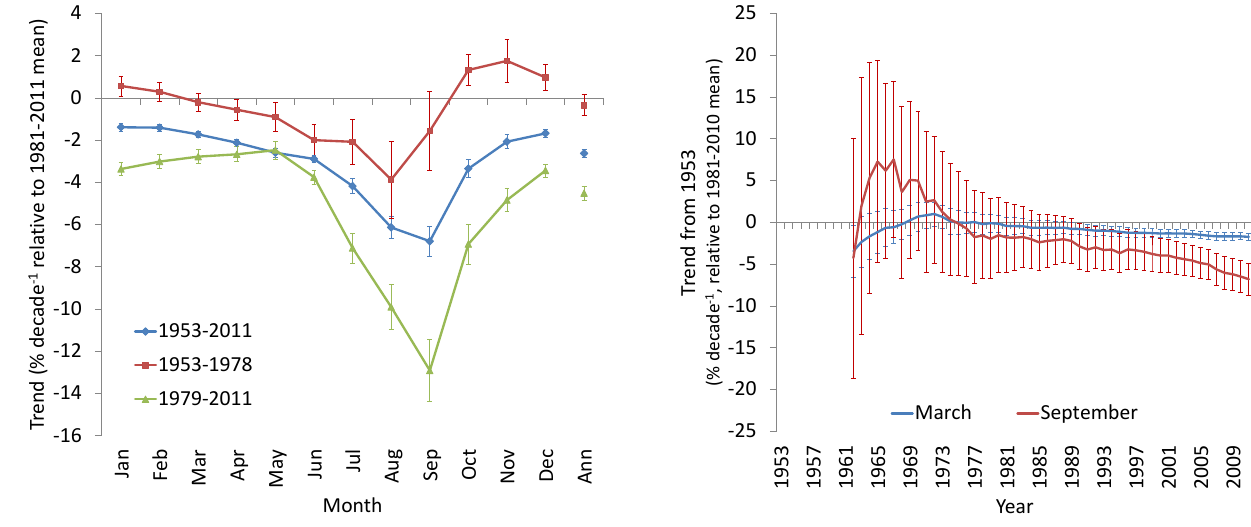
Fig. 3. Trend and trend significance level for period starting in 1953 and ending the plotted year for March and September. The error bars represent the 99% confidence level. Error bars that cross the origin indicate a trend that is not statistically significant at the 99%